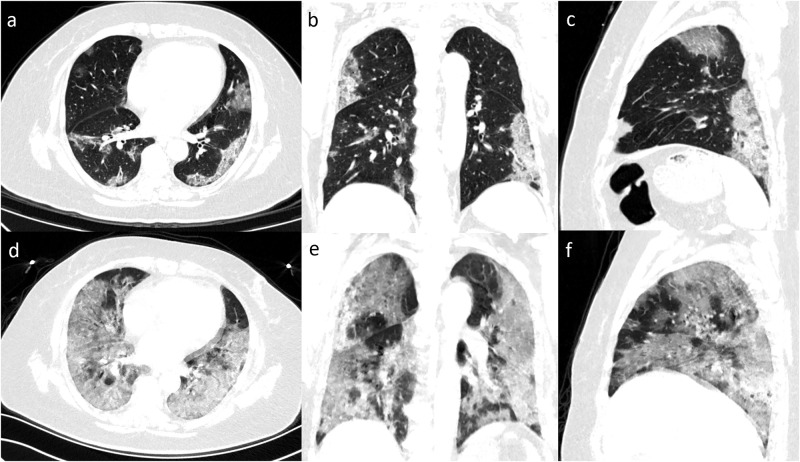
Serial chest images of a 57-year-old man with fever and dry cough.(a-d) 12 days before the death, chest CT with axial, coronal, sagittal planes showed moderate lung involvement with a total CT score of 11, with subpleural ground-glass opacities and patches of consolidation in bilateral lungs. (e-f) 4 days before the death, chest CT with different planes showed severe lung involvement with a total score of 20, with the appearance of the white lung.